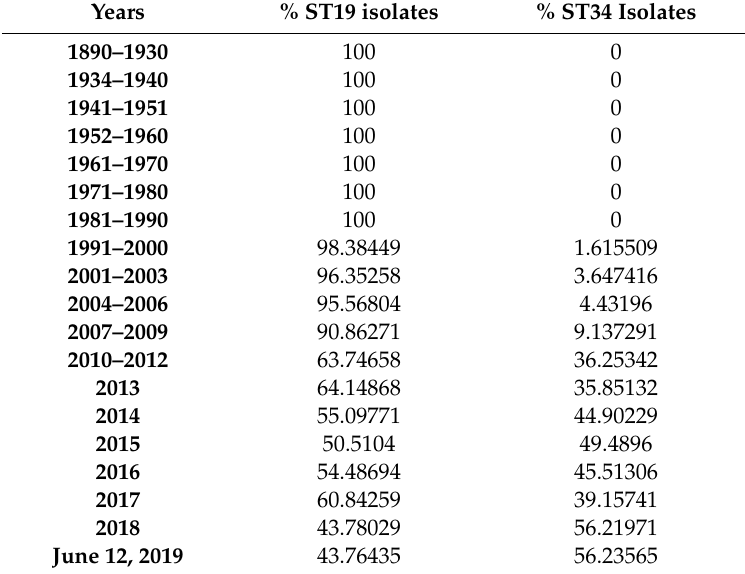
Table 1. A comparative analysis of the percentage (%) of isolates of ST19 and ST34 from 35,963 Salmonella Typhimurium isolates of the Enterobase [16] shows the increase in the % of ST34 isolates in recent years. Years % ST19